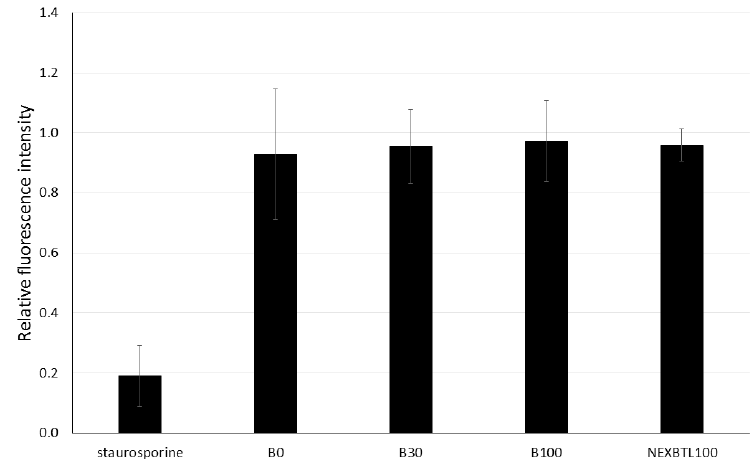
Figure 4. Relative GSH levels upon 4 h exposure to DEP extracts. Results are expressed as ratios of fluorescence intensity of treated and untreated cells. Cells were incubated with 50 µg/mL of different DEP extracts and staurosporine (1 µg/mL) as a positive control. No significant changes between the samples treated with individual DEP extracts and the control sample were found.